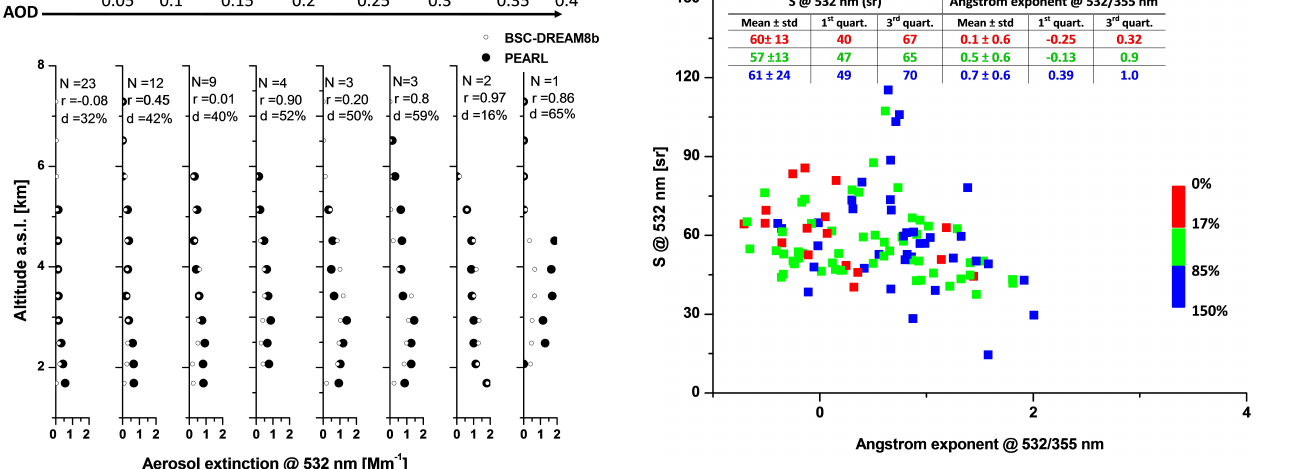
Figure 6. Mean aerosol extinction profiles separated into AOD classes. The number of measurements (N), the linear correlation coefficient among measured and modeled profiles (r) and the mean relative difference (d) are reported.